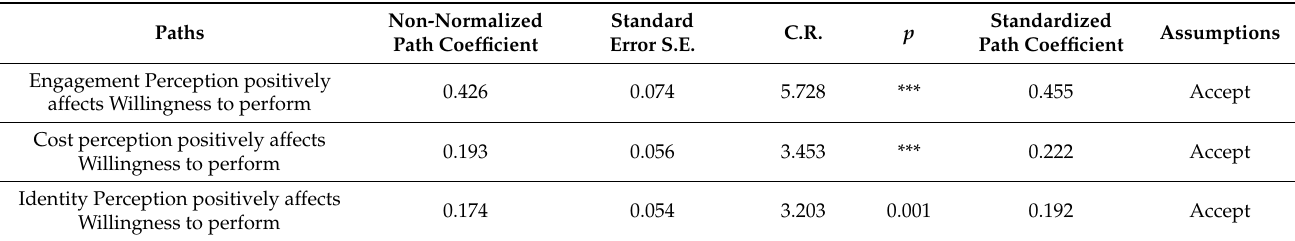
Table 13. Path coefficients between the